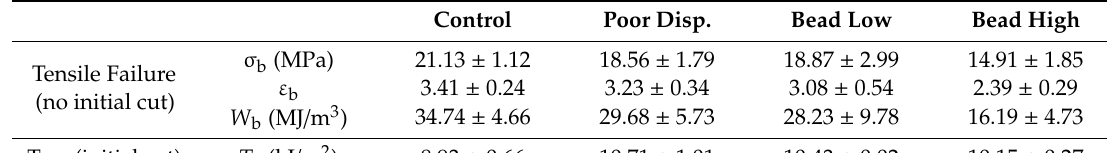
Table 2. Ultimate Tensile and Tear Properties.